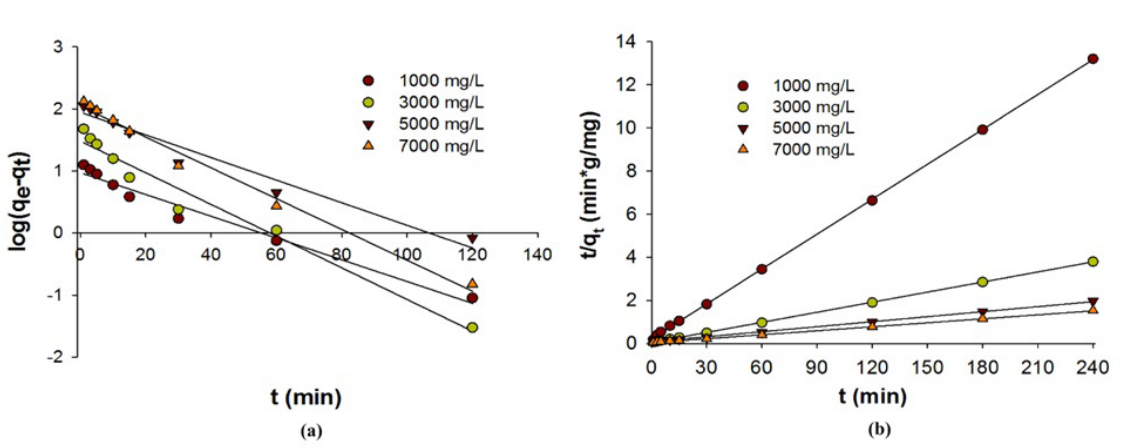
Figure 8: The fit to the adsorption of Amano Lipase A onto Stöber silica support using (a) pseudo-first-order and (b) pseudo-second-order